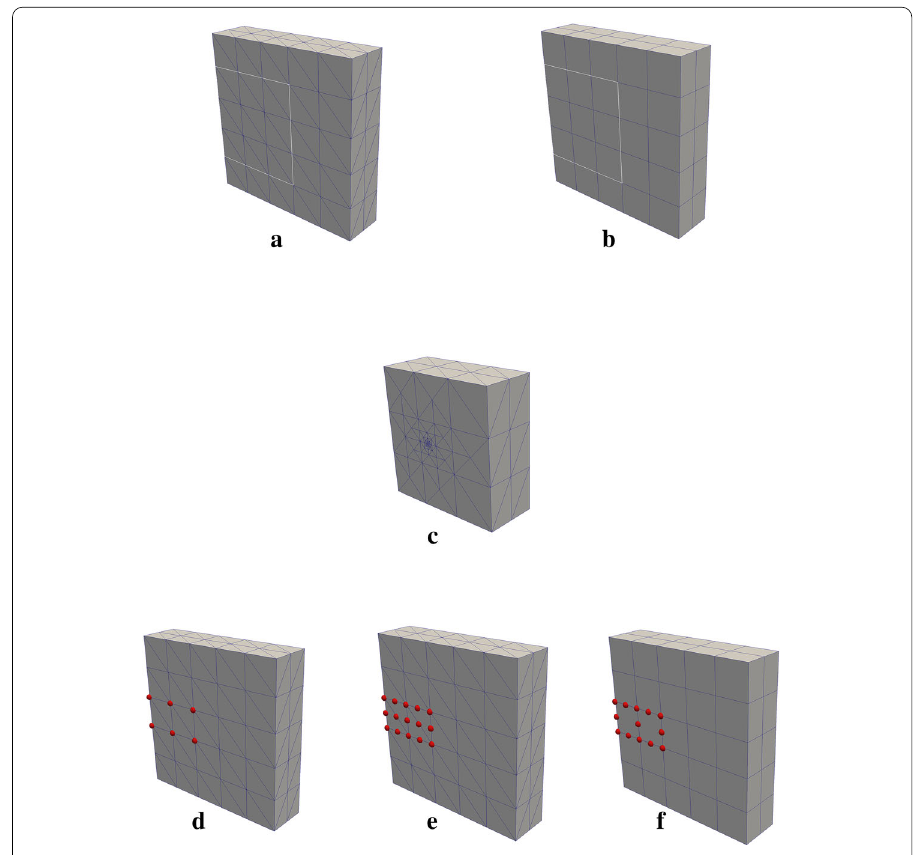
Fig. 11 Meshes used for the GFEM gl analysis of a 3-D edge crack— a TET4/TET10 initial global mesh— b